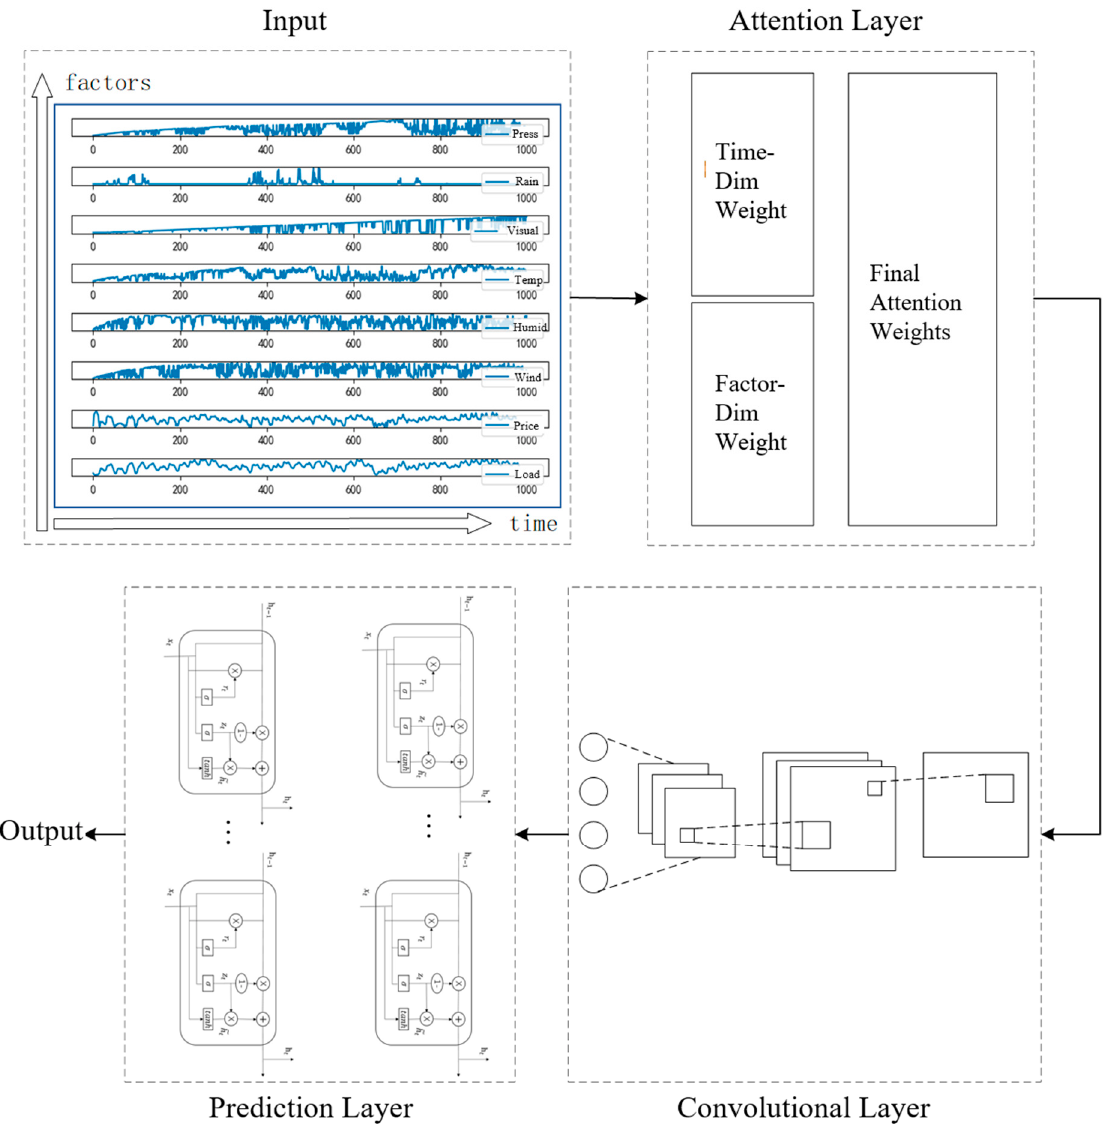
Figure 1. Multivariate load prediction model based on a pre-attention mechanism and convolutional neural